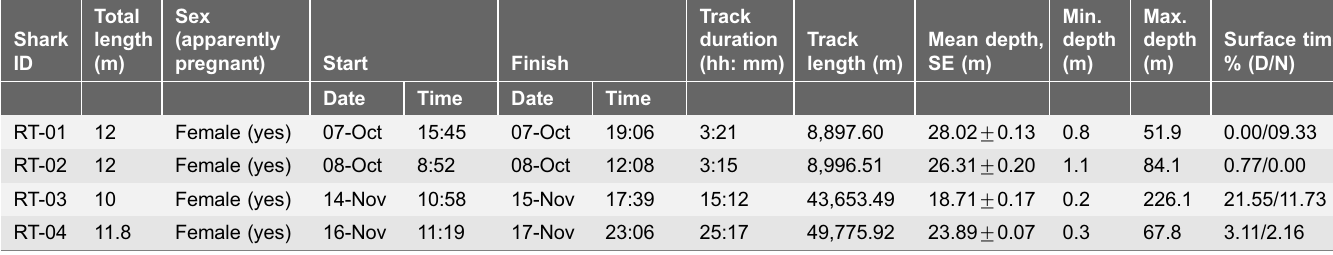
Table 2. Summary of R. typus tracks at Darwin Island in 2013. Total Shark ID